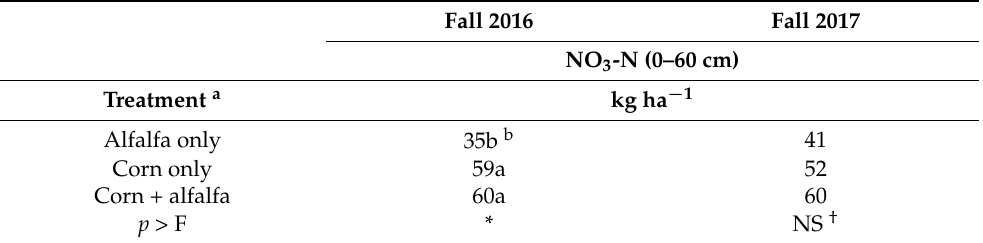
Table 6. Residual soil NO 3 -N in late fall for seeding year of alfalfa in 2016 and 2017. Fall